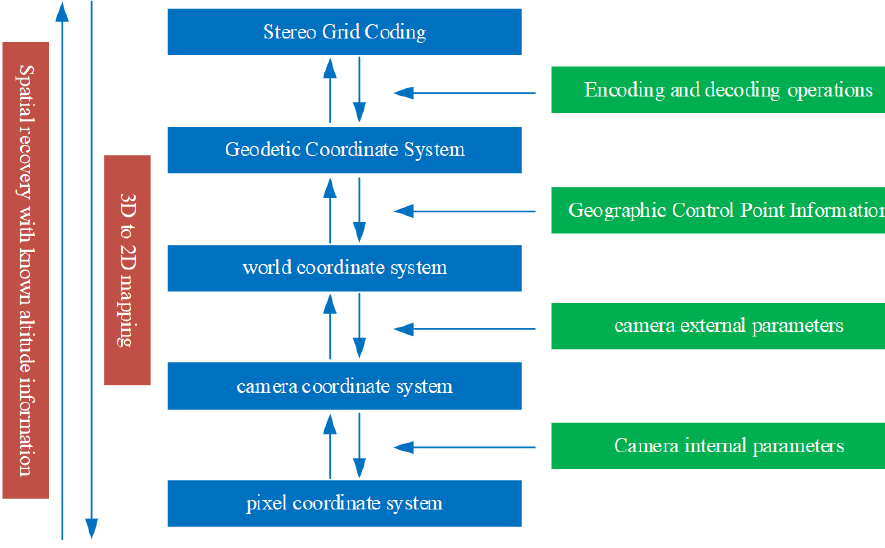
Figure 2. Model Technical